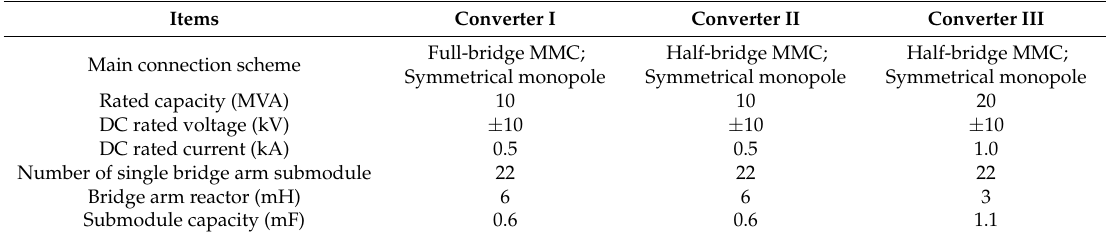
Figure 1. Topology of the ± 10 kV three-terminal DC distribution system. Table 1. Parameters of converter stations in the three-terminal DC distribution system.